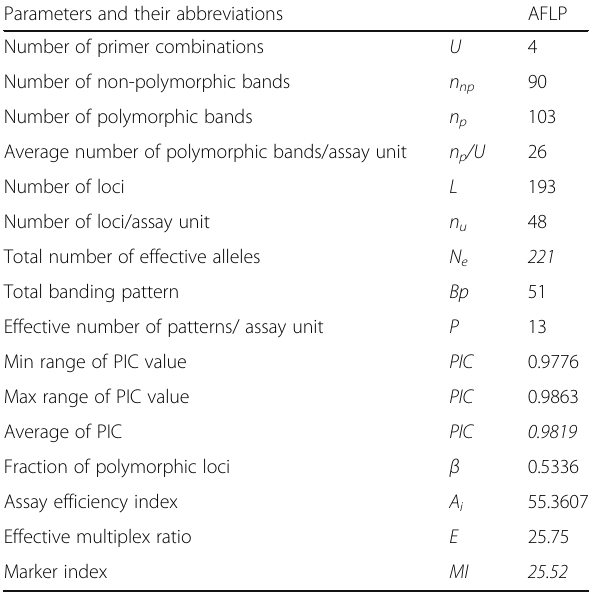
Table 3 Information obtained from AFLP using four